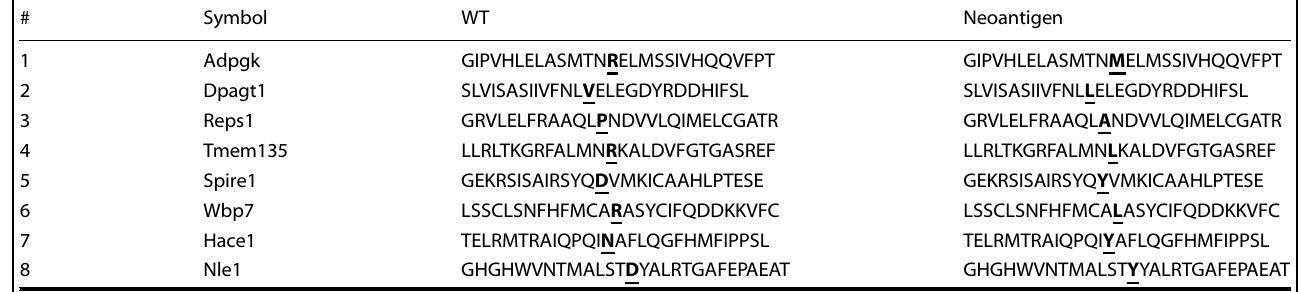
Table 1. M8 vaccine expressing MC38 neoantigens (see Fig. 1).